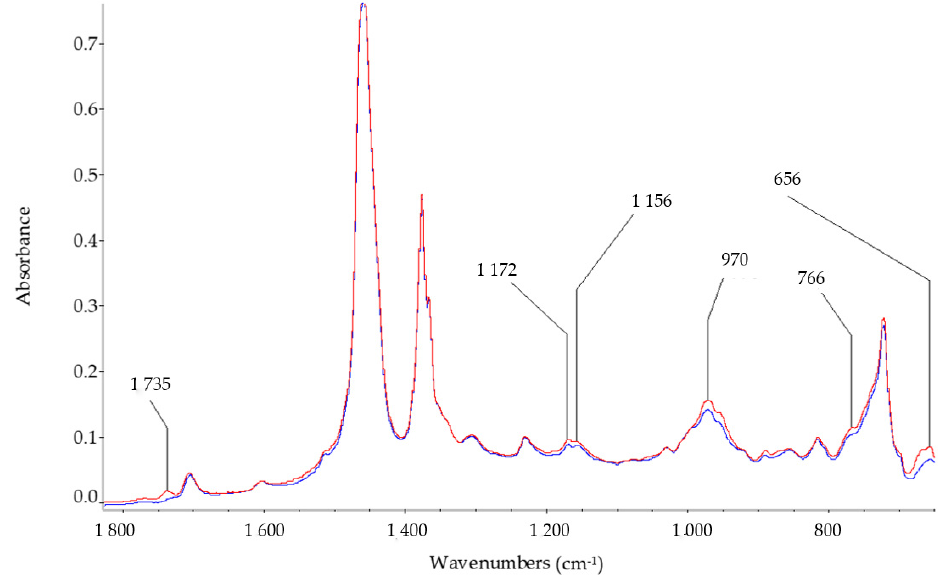
Figure 4. The spectra of engine oil with different TBN values in the spectral range 1780–650 cm − 1 .